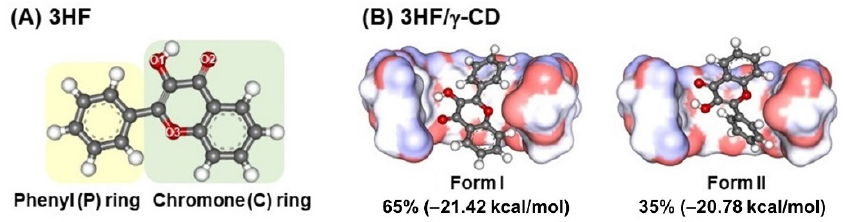
Figure 1. ( A ) Chemical structure of 3-Hydroxyflavone, 3HF. ( B ) Docked structures of the two possible 3HF/ γ -CD complexes, Form I and Form II, where their percentage of occurrence and the lowest interaction energy retrieved from 100 independent docking runs are also given.